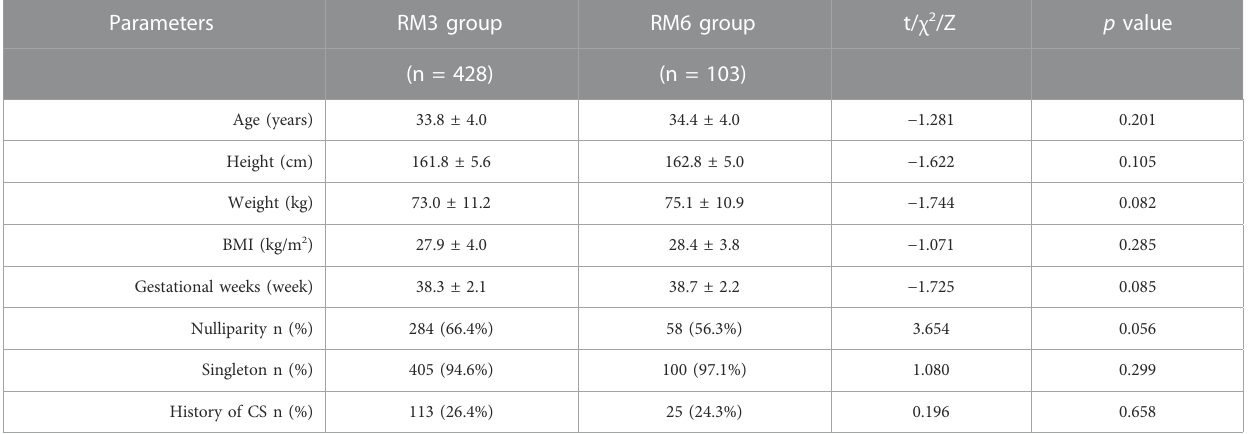
TABLE 1 Demographic and clinical characteristics of parturients.